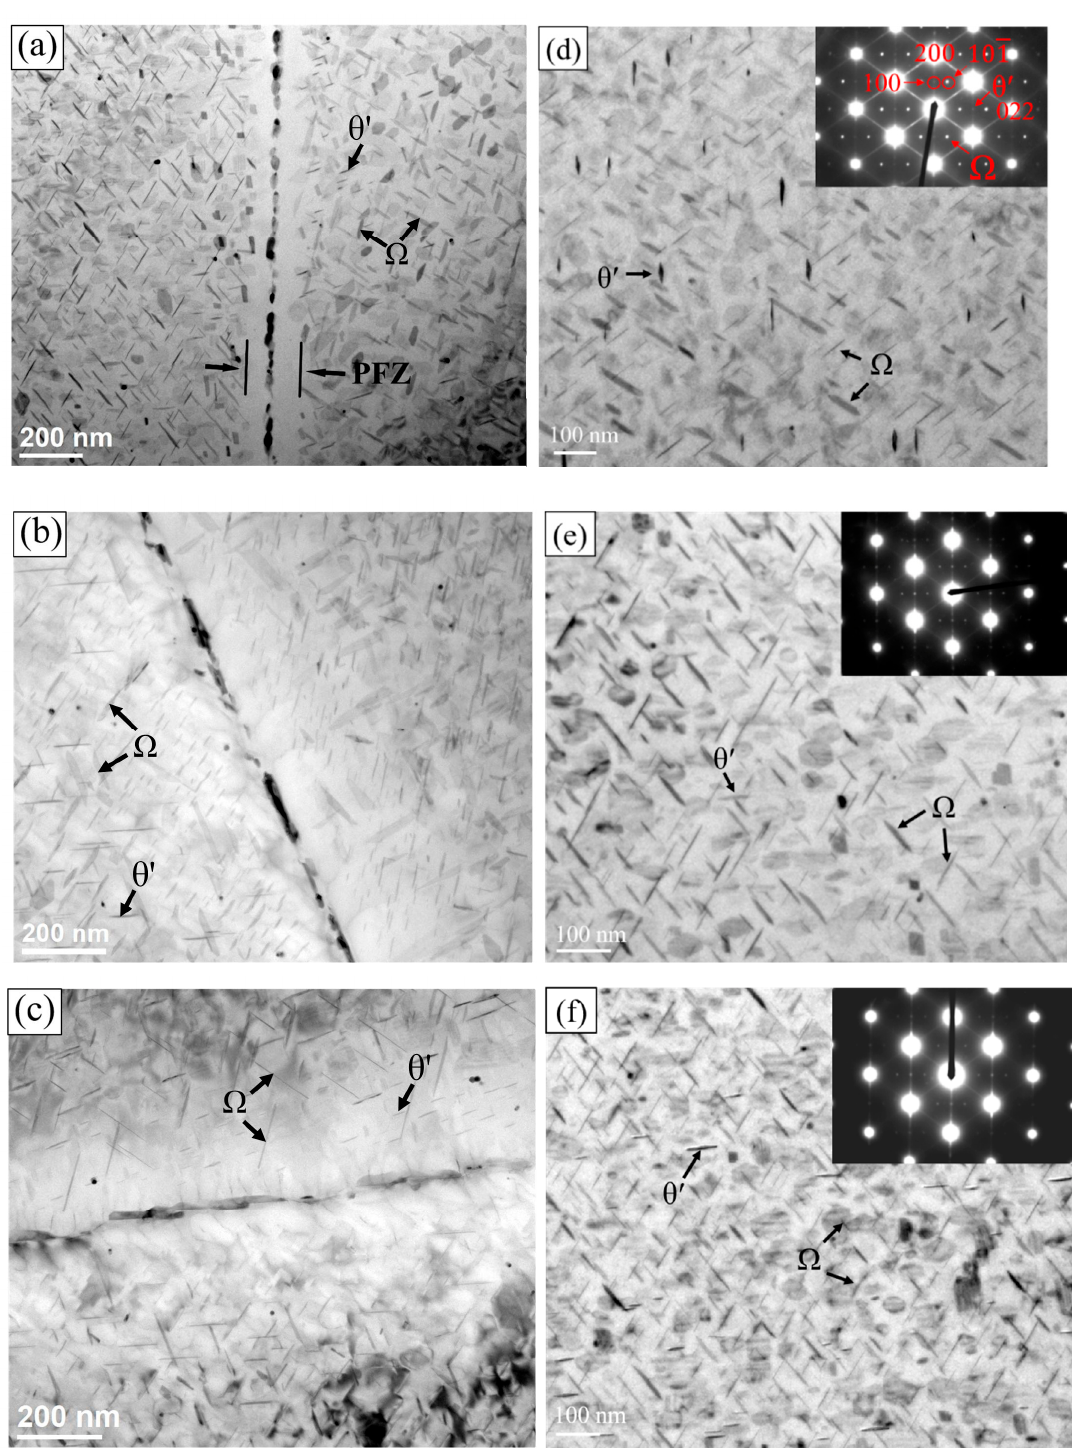
Figure 5. TEM bright field images and the selected area electron diffraction pattern (SAED) of: ( a , d ) Alloy NA0d; ( b , e ) Alloy NA1d; ( c , f ) Alloy NA4d after T7 tempering.